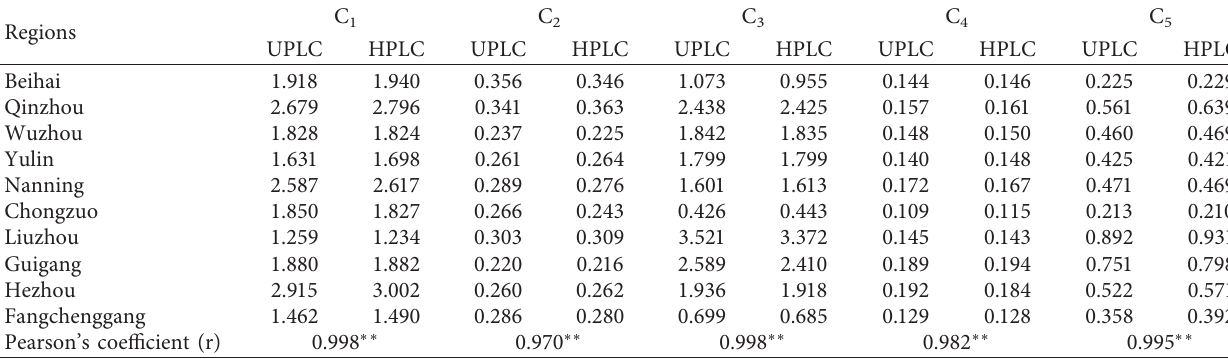
Table 5: Determination of 5 constituents using different instruments (mg/g, n � 3).